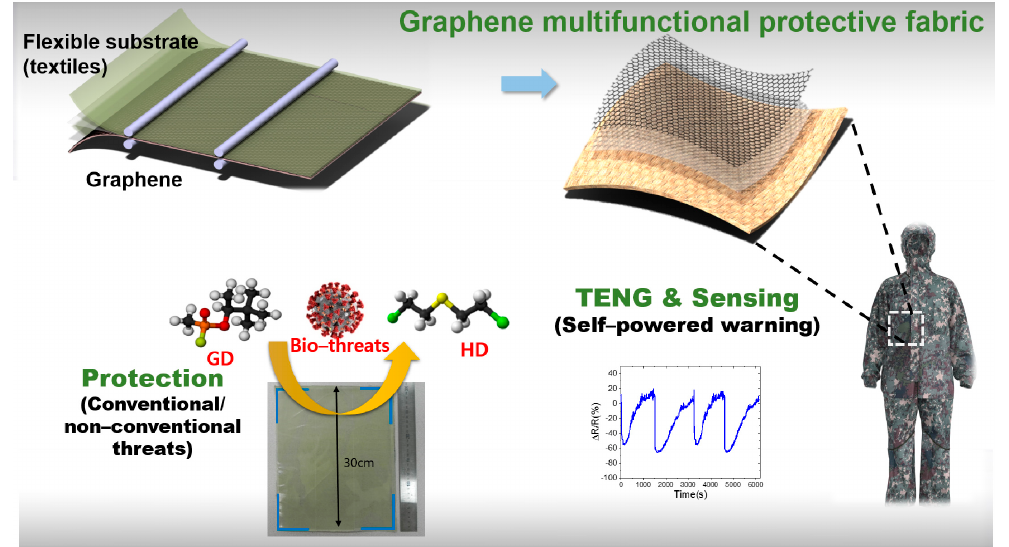
Figure 1. Schematics of graphene multifunctional protective fabrics.